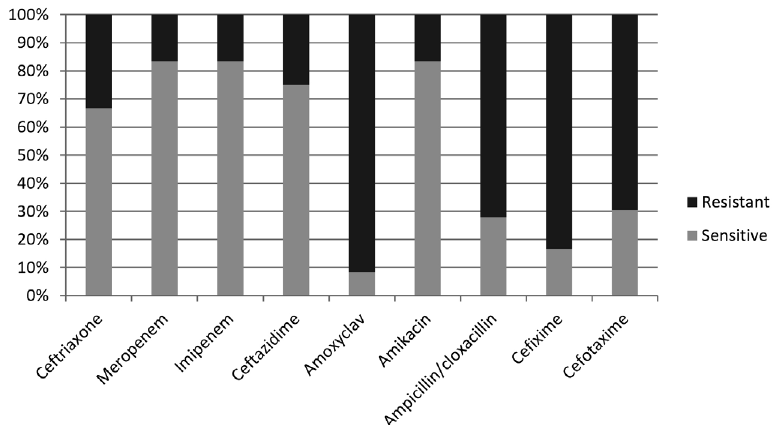
Fig. 1. Percentages of antibiotic sensitivity and resistance of Proteus